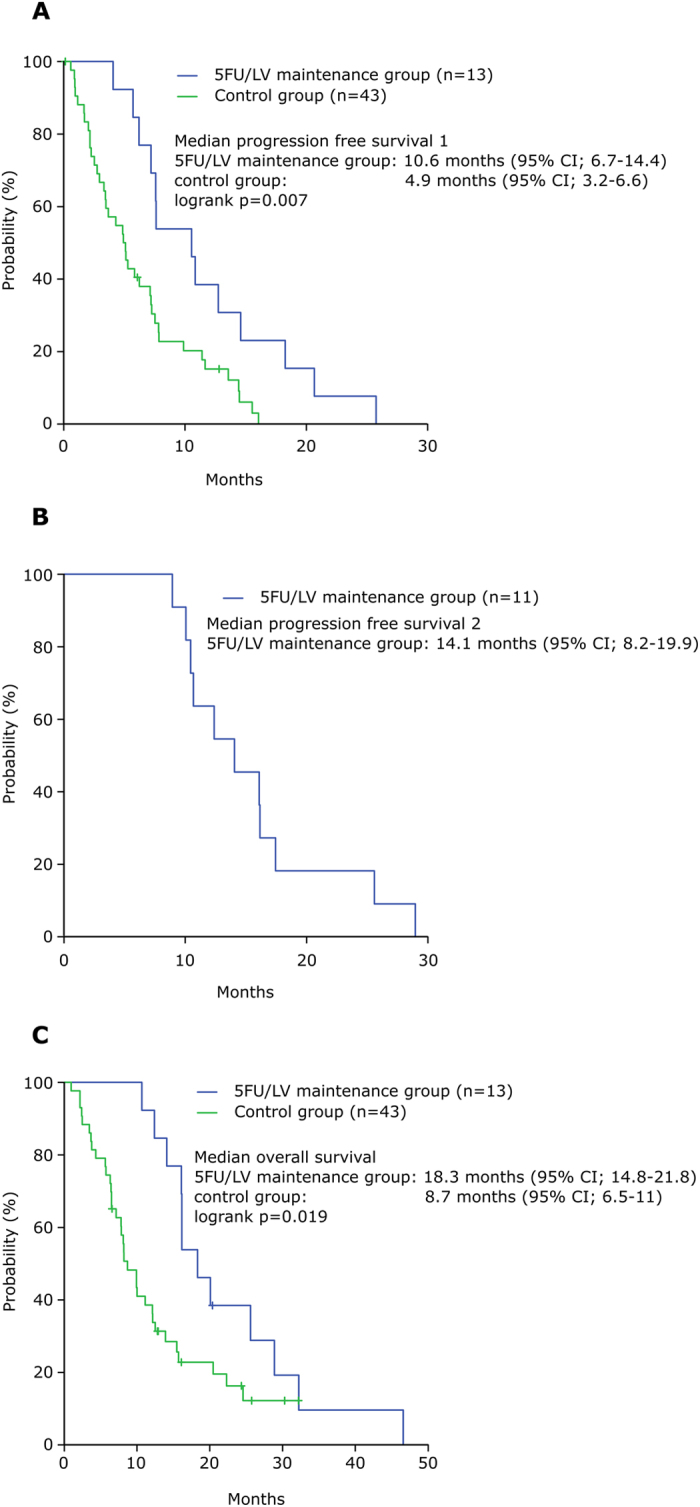
PFS1, PFS2 and OS.